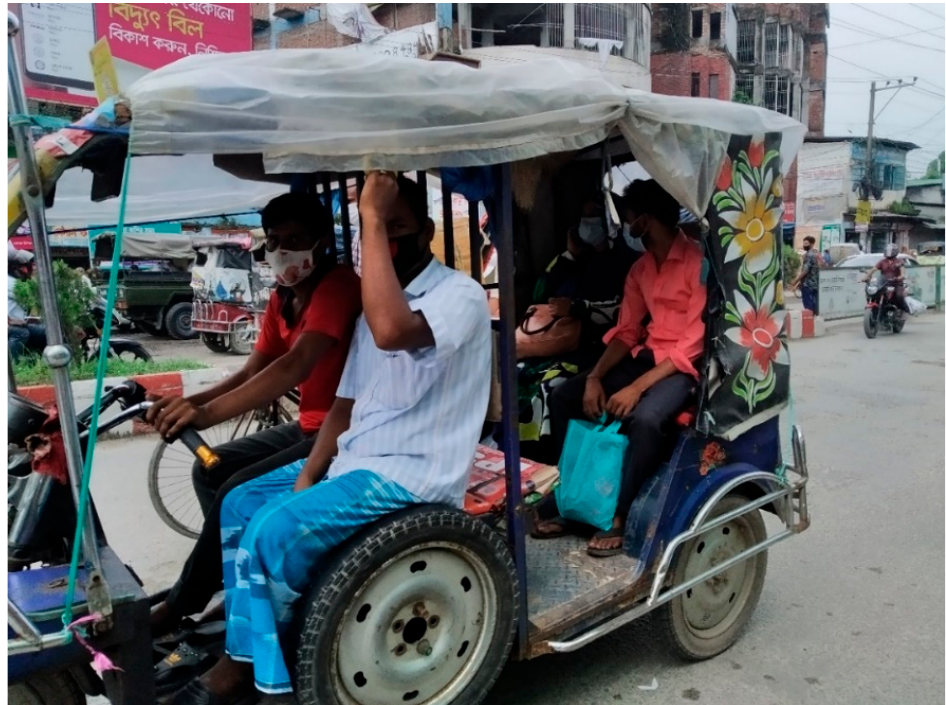
Figure 5. Driver and passengers riding an easy-bike in Rangpur city.